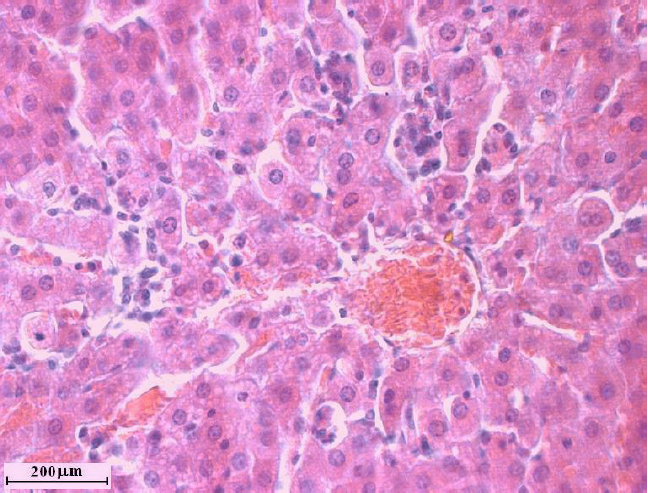
Figure 3. Liver cross section of rats treated with one dose of carbon tetrachloride.